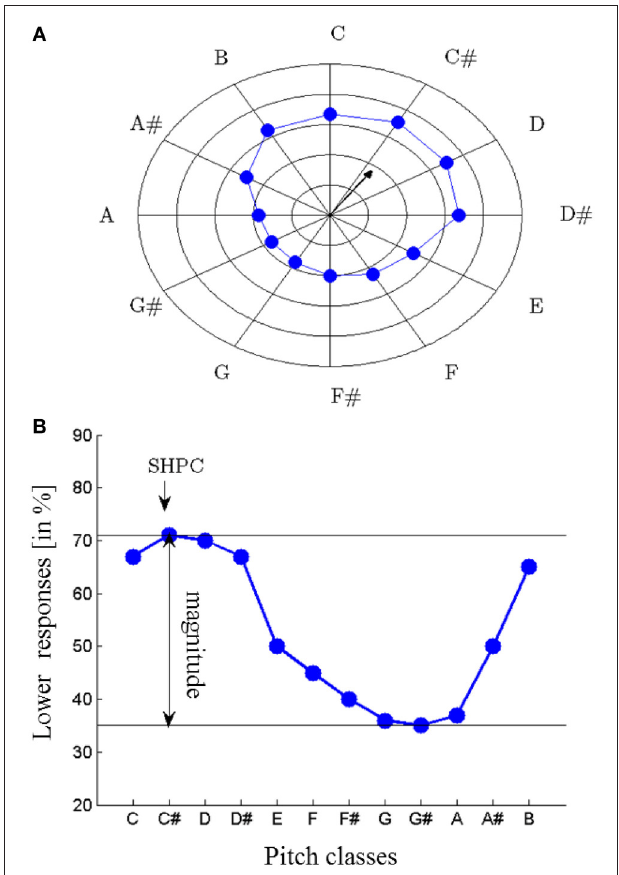
FIGURE 2 | Subjectively highest pitch class (SHPC) and magnitude of effect are extracted from the proportion of lower judgments as a function of the initial pitch classes of tritone pairs; plotted in a radial response graph (concentric circles: increments of 20%, A ) and as response function (B) ; the SHPC is given by the direction of the resultant vector of the data points (A) ; for more details (see Fisher, 1993) and is nearly the point of the maximum proportion of lower responses (B) ; magnitude of effect is the difference between maximum and minimum of the response function; in this example, the SHPC is approximately at C# and the magnitude of effect is about